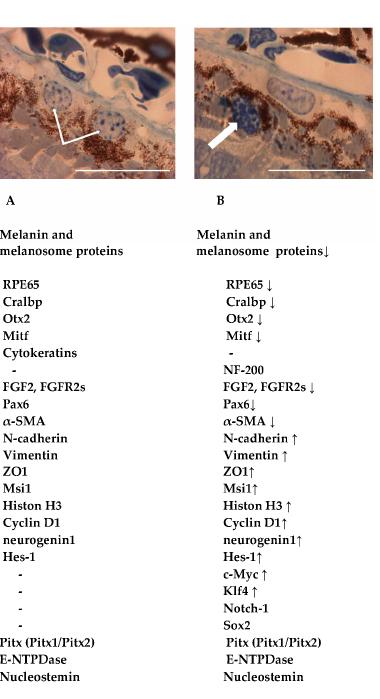
Figure 1. Accumulated data on morphological and molecular features of native retinal pigment epithelium (RPE) cells and those at the beginning of natural reprogramming to neuronal and glial cells of regenerating retina [6,7,11–14,17–24]. ( A ) RPE cells (thin white arrows) in the RPE layer of the newt Pleurodeles waltl ; ( B ) RPE cell that left its layer and stays at the beginning of reprogramming (thick white arrow); Scale bar: 100 µm. See details in the text. Down- ( ↓ ) and up- ( ↑ ) regulation of gene/protein expression.